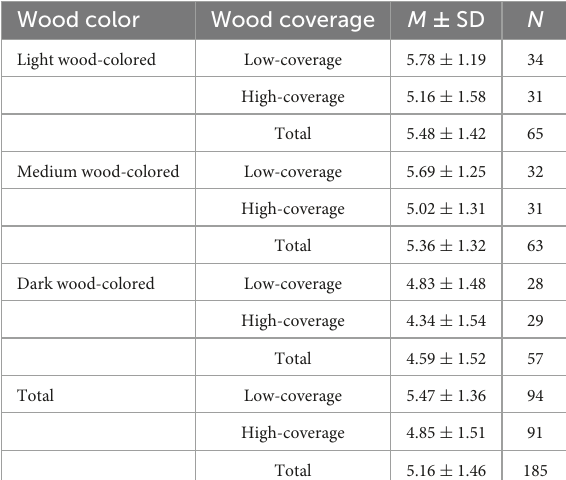
TABLE 6 Usage willingness